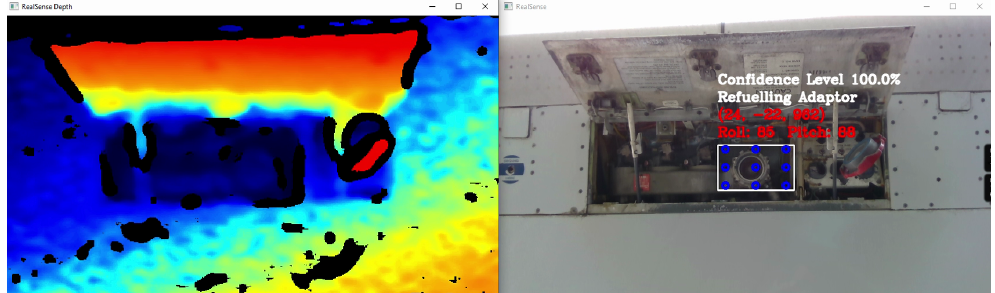
Figure 5. Real-Time Detection in RGB and Depth Stream on Boeing